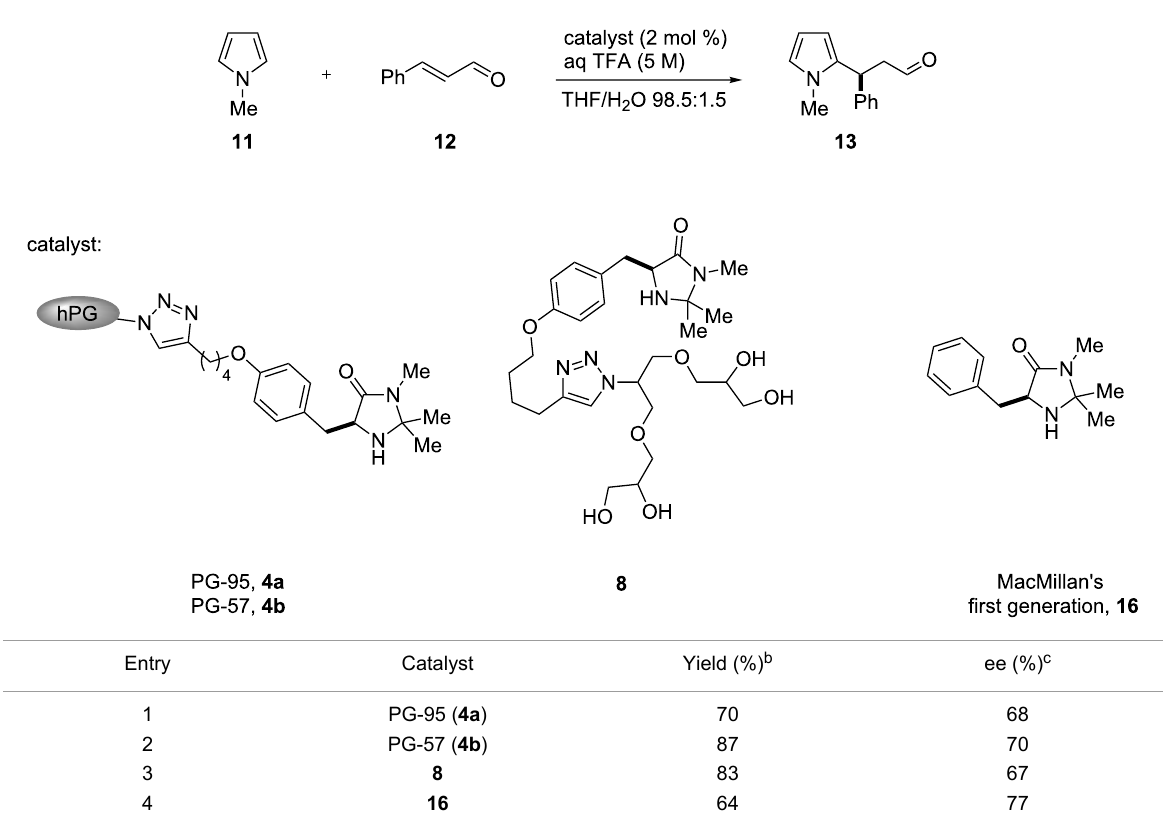
Table 6: Comparison of hPG catalysts 4a,b with monovalent analogue 8 and MacMillan’s first generation 16 . a